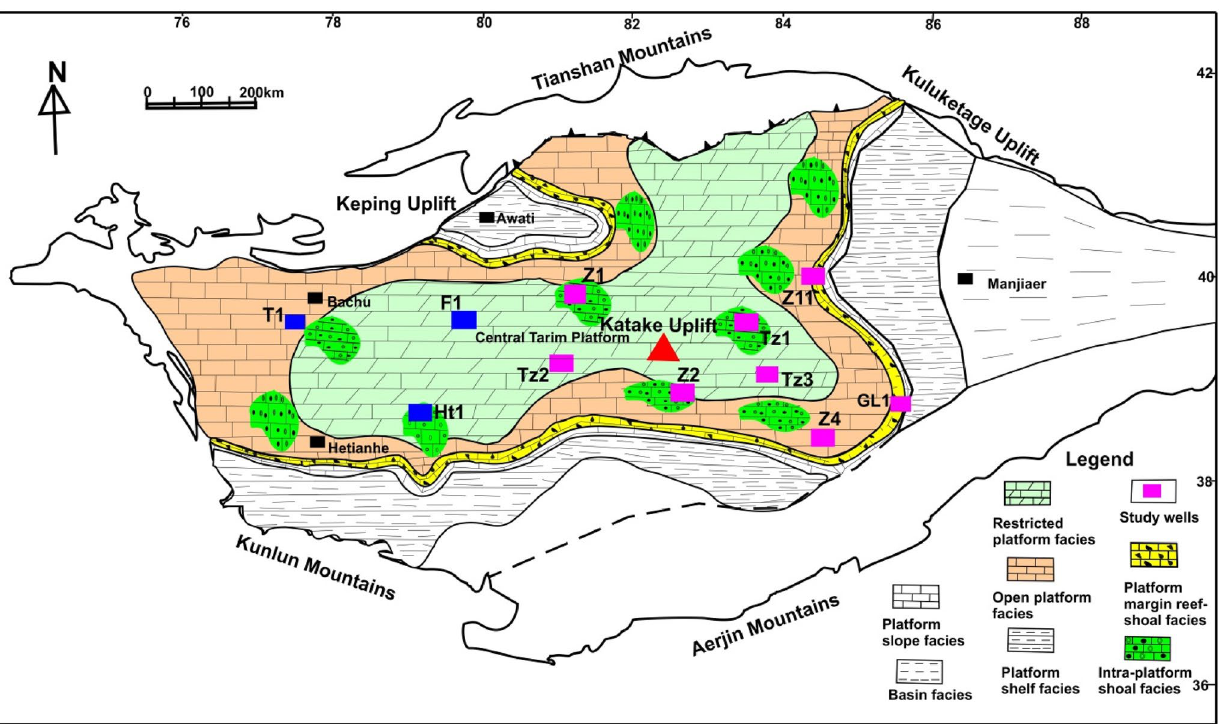
Fig. 2 Paleogeography and sedimentary facies of the Lower Ordovician in the Tazhong Uplift in central Tarim basin: note the location of the study wells on the carbonate platform in the central parts of the basin. (Modified from Gao and Fan 2014a, 2015)